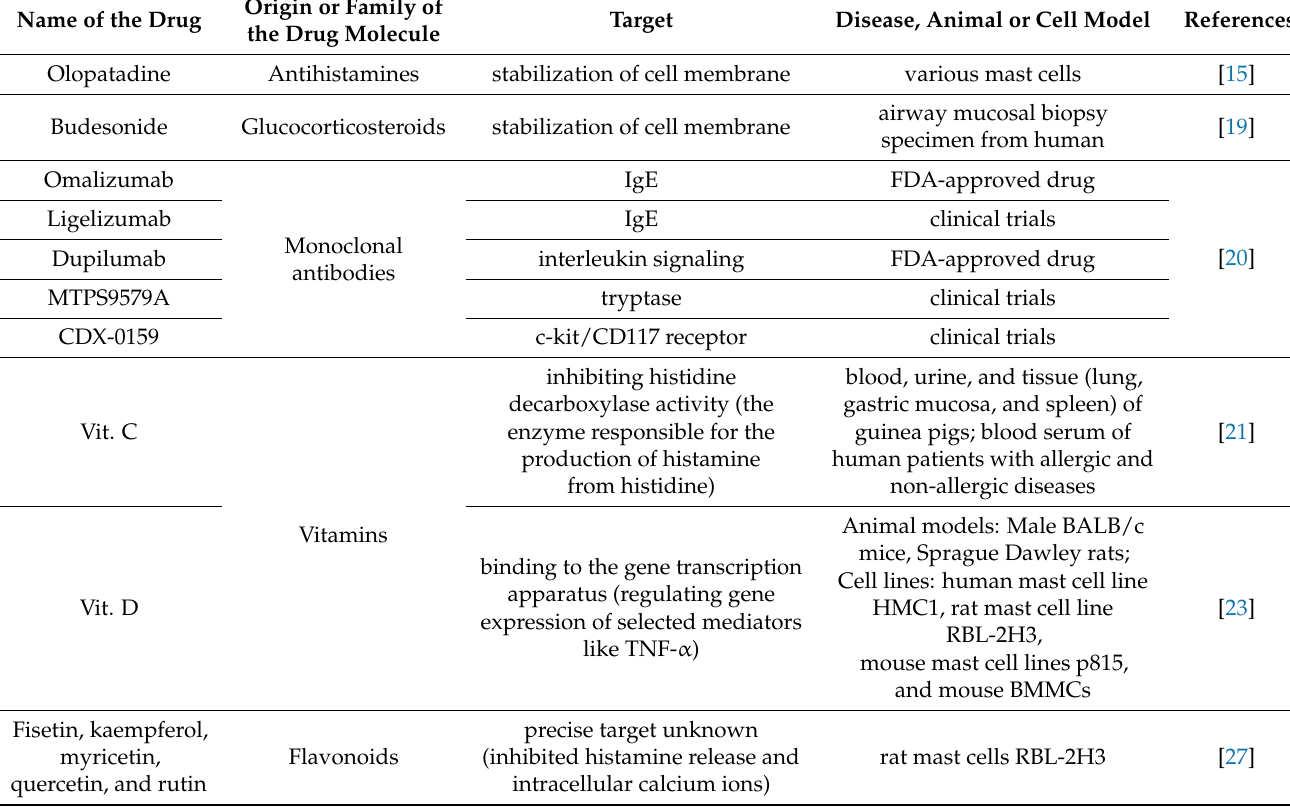
Table 1. Compounds and drugs inhibiting mast cell